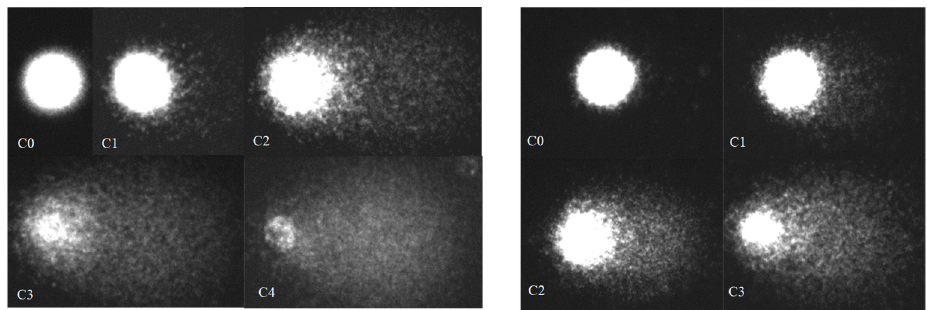
Figure 1. Comet images of the lung ( left ) and liver ( right ) cells in control and Paragonimus heterotremus ‐ infected rats for different DNA damage classes (0–4).